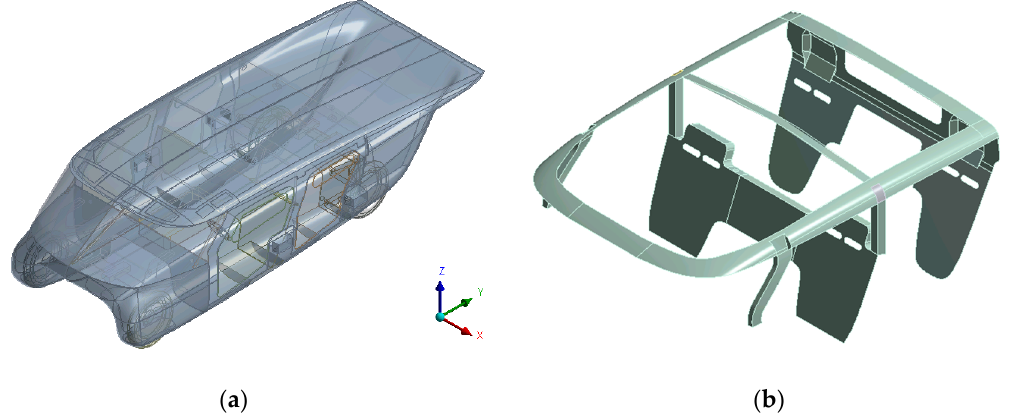
Figure 1. The multi-occupant solar vehicle: ( a ) general layout; ( b ) roof support structure.